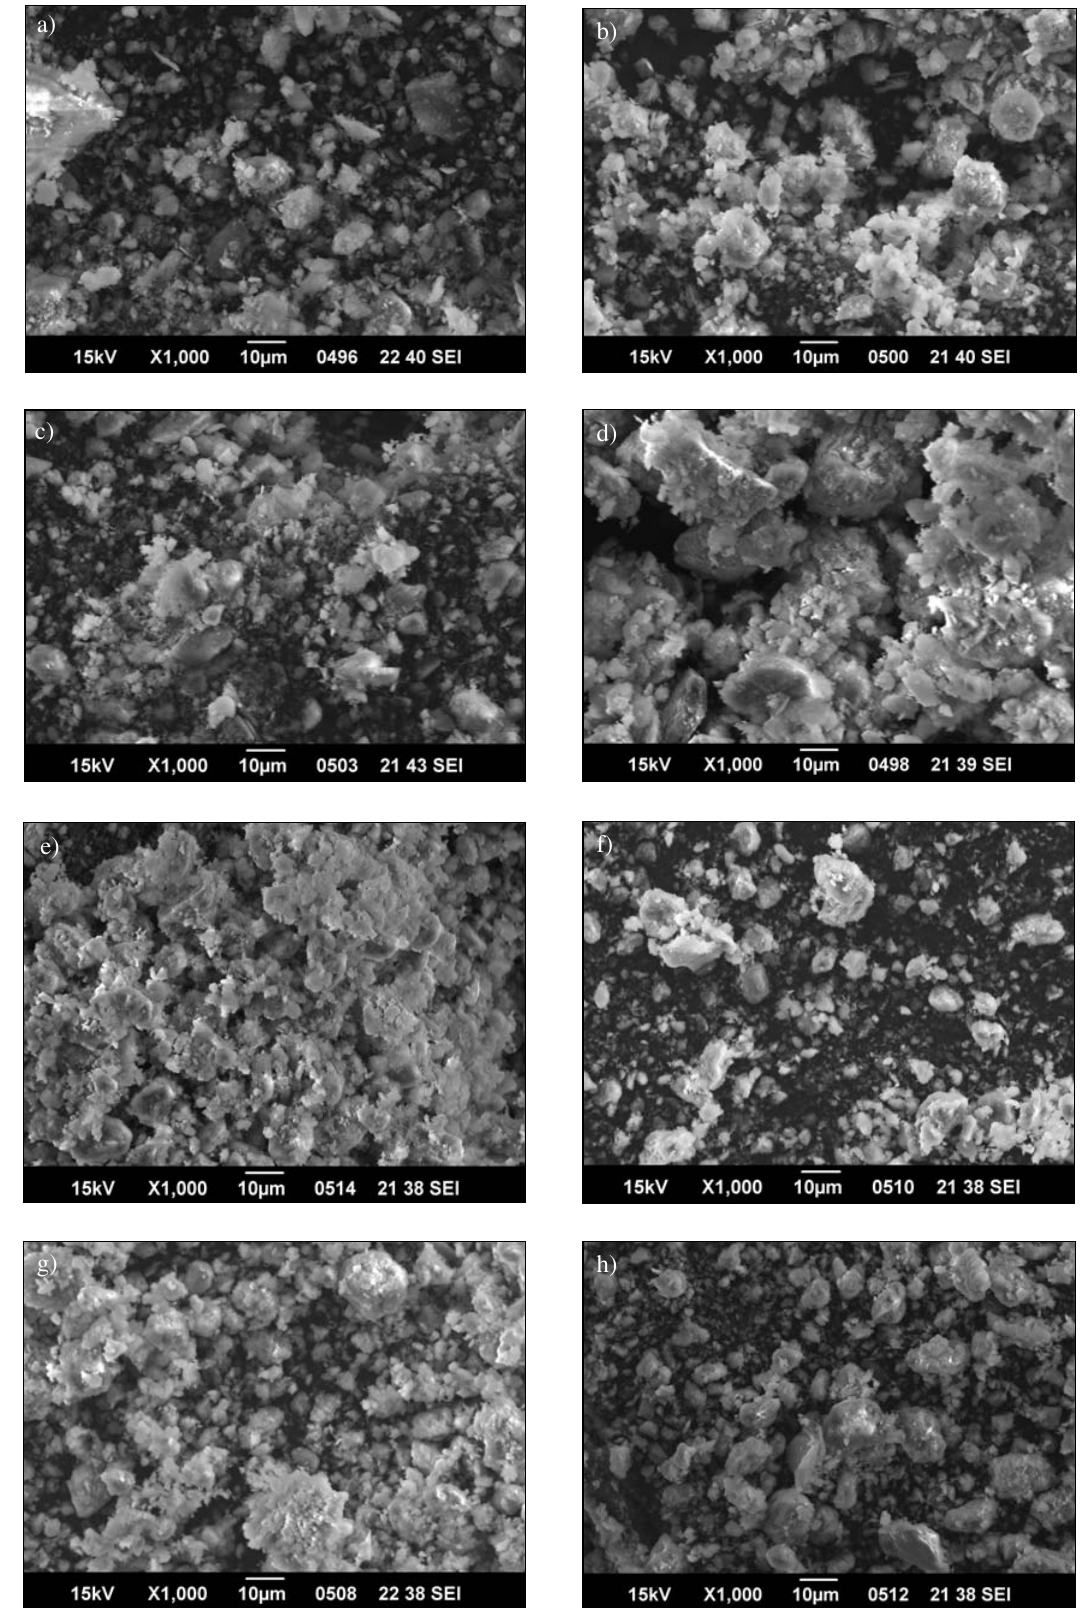
Table 7. Example of elemental composition (weight and atomic %) for each type of studied material for a 65 seconds collection time